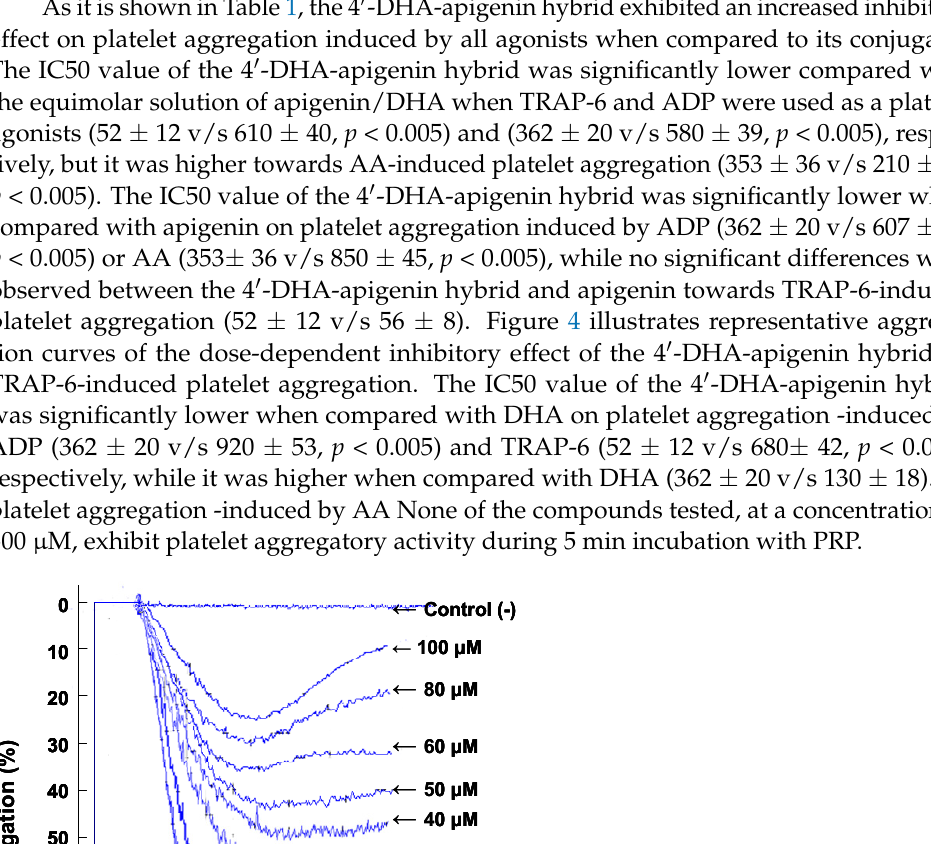
Table 1. IC50 values of the inhibitory effect of 4 (cid:48) -DHA-apigenin hybrid, apigenin/DHA (equimolar solution), apigenin and DHA on AA, ADP and TRAP-6-induced platelet aggregation. AA ADP TRAP 6 Compounds IC50 ( µ M) IC50 ( µ M) IC50 ( µ M) 4 (cid:48) -DHA-apigenin hybrid 353 ± 36 * 362 ± 20 § 52 ± 12 # i. Apigenin/DHA equimolar solution 210 ± 25 580 ± 39 610 ± 40 ii Apigenin 850 ± 45 607 ± 35 56 ± 8 iii. DHA 130 ± 18 920 ± 53 680 ± 42 The values are the mean ± SD from three different platelet preparations. * ,§,# p < 0.005, compared with the inhibitory effect of: (i) apigenin/DHA equimolar solution, on platelet aggregation induced by AA, ADP and TRAP-6, (ii) apigenin, on platelet aggregation induced by AA and ADP, and (iii) DHA, on platelet aggregation induced by ADP and TRAP-6, respectively. As it is shown in Table 1, the 4 (cid:48) -DHA-apigenin hybrid exhibited an increased inhibitory effect on platelet aggregation induced by all agonists when compared to its conjugates.